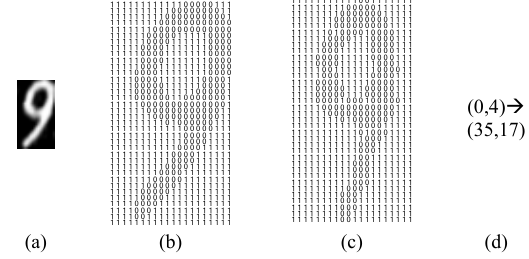
Fig. 5. Locating the character in a leaning gray image by DNRBM (a) original image (b) after distinguishing foreground from background (c) after turning left with 10 degrees (d) the location of the foreground got after cutting